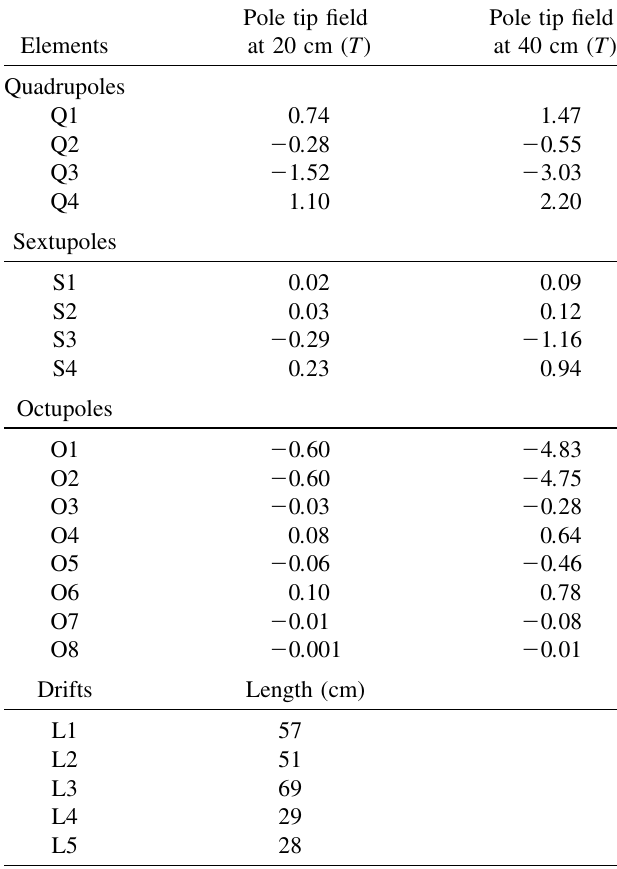
TABLE I. Parameter list for the case of a beam of 8 Tm rigidity. The drifts, quadrupoles, and sextupoles are for one cell only in the order they appear in the beam line (from left to right in the figures). The 8 octupoles are from the first two cells in the order they appear in the beam line. The remaining elements are given by the symmetries detailed in Sec. IV. Some generic fringe fields are taken into account. The numerical values of the magnet strengths depend on the specific fringe field model applied. We note that, due to the large strengths of the first two octupoles, the octupole windings might be on a smaller bore than the rest of the coils since the beam size is small at the location of the respective multipoles. Also, work in progress on more advanced optimization methods might result in solutions with reduced octupole strengths. Pole tip field Pole tip field Elements